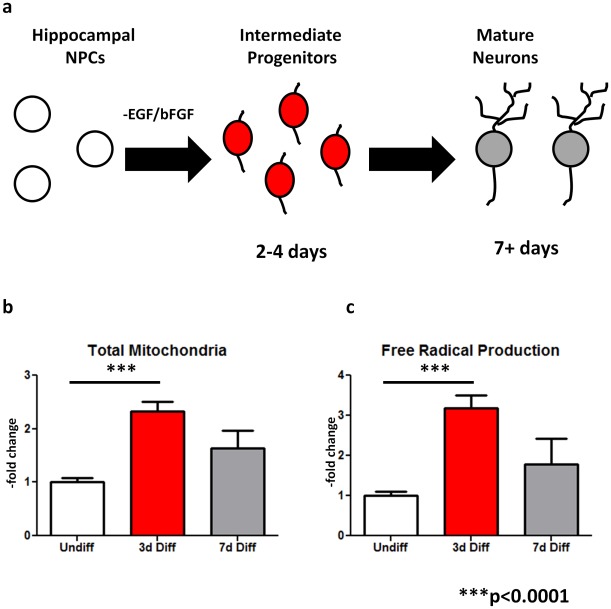
Hippocampal neurogenesis transiently generates oxidative stress.(a) Total mitochondria and oxidative load were measured in undifferentiated NPCs, early progenitors and postmitotic neurons. (b, c) Total mitochondria prevalence was measured via Mitotracker biological dye (b) while total oxidative load was measured using Mitosox biological indicator dye (measured as–fold change compared to undifferentiated NSCs). Quantifiable fluorescence emission measurements demonstrate a significant increase in maximal mitochondrial abundance and peak oxidative load occurs during the period enriched for early progenitors. p*<0.0001.